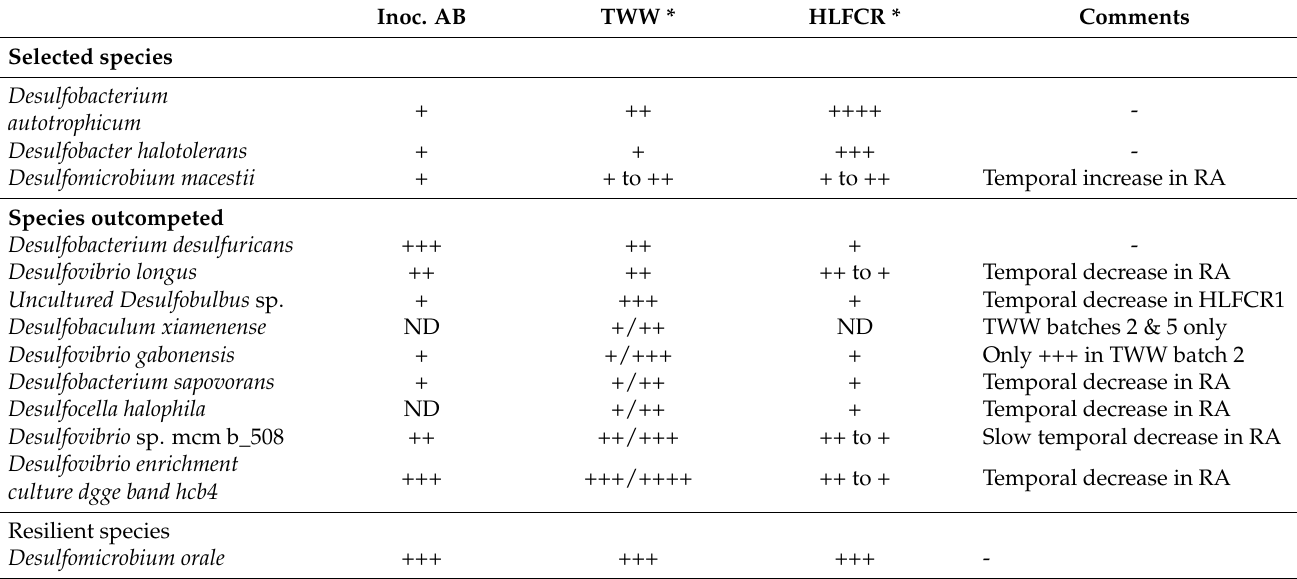
Table 3. Semi quantitative analysis of abundance of different dsrB containing bacterial species. Inoc. AB TWW